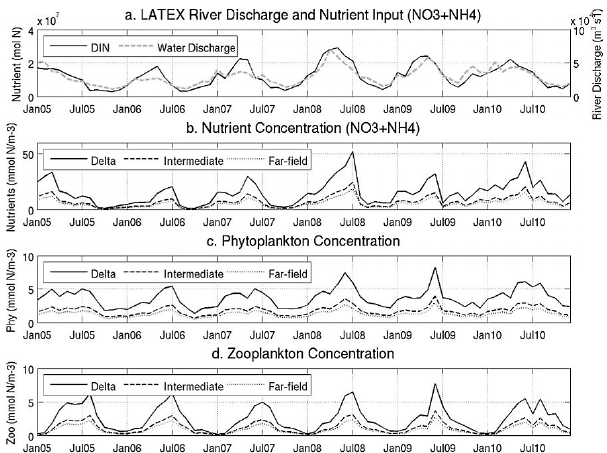
Fig. 9. Monthly mean time series of (a) river discharge and DIN loading, (b) surface DIN concentration, (c) surface phytoplankton concentration, and (d) surface zooplankton concentration in each of the three analysis regions (Delta, Intermediate, Far-field) on the LATEX